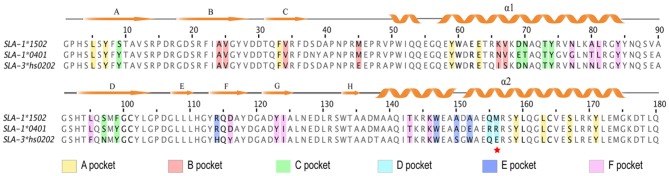
Structure-based amino acid sequence alignment of SLA-1*1502, SLA-1*0401, and SLA-3*hs0202 alleles. The amino acid sequences of the PBGs of SLA-1*1502, SLA-1*0401, and SLA-3*hs0202 were aligned, and the secondary structural elements are indicated above the sequences. Orange arrows indicate β-strands, and orange cylinders denote α-helices. The residues in pockets A-F are highlighted with different colors. The residues at position 156 in the D pocket are indicated with a red star.